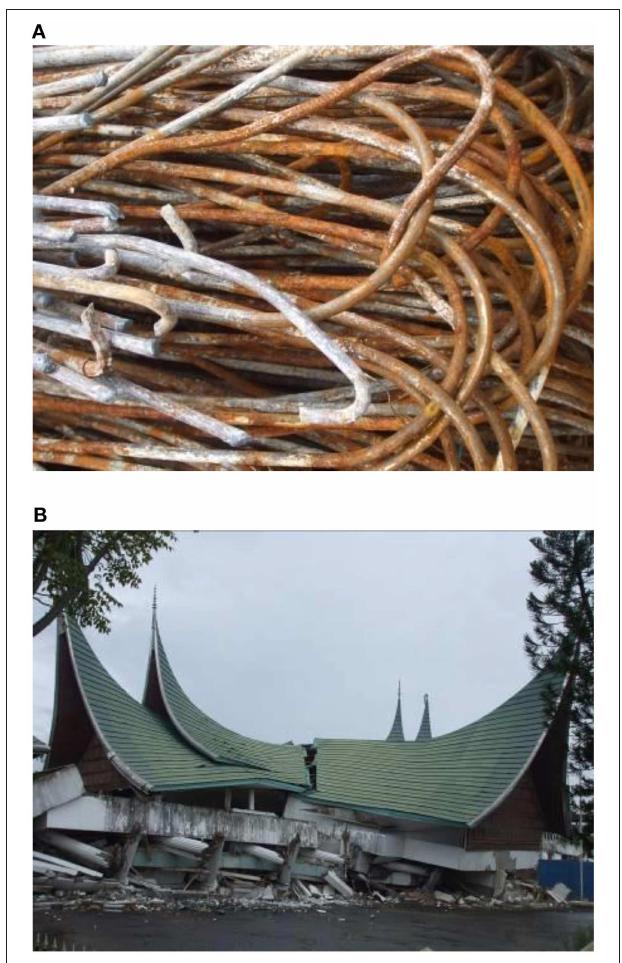
FIGURE 4 | Deficiency in reinforcement and typical collapse mode. (A) Smooth plain bars used as main reinforcements (found in a collapsed shophouse) at Padang city. (B) Soft story collapse of the Public Works building at Padang